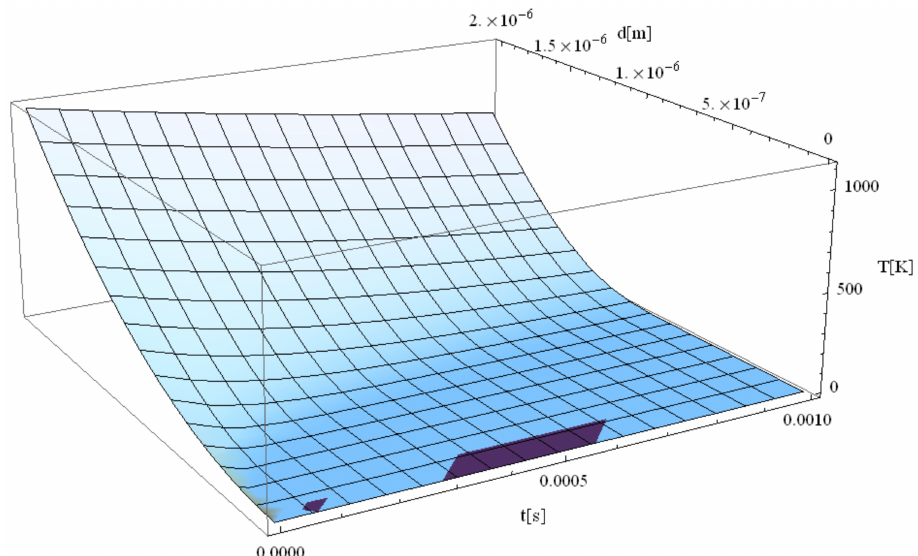
Figure 9. Electron temperature versus radius during 1 ms simulation after irradiation with a 100 as laser pulse applied to an Au